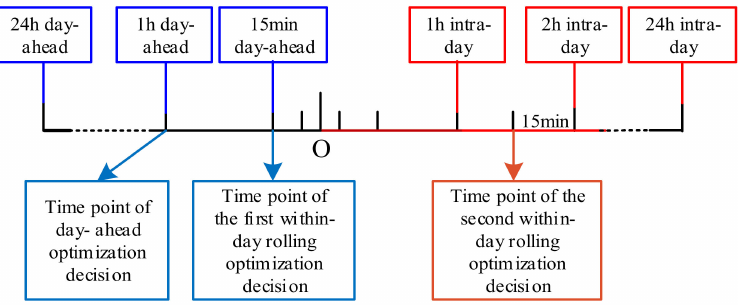
Figure 7. The decision time scheme of day-ahead and intra-day rolling robust